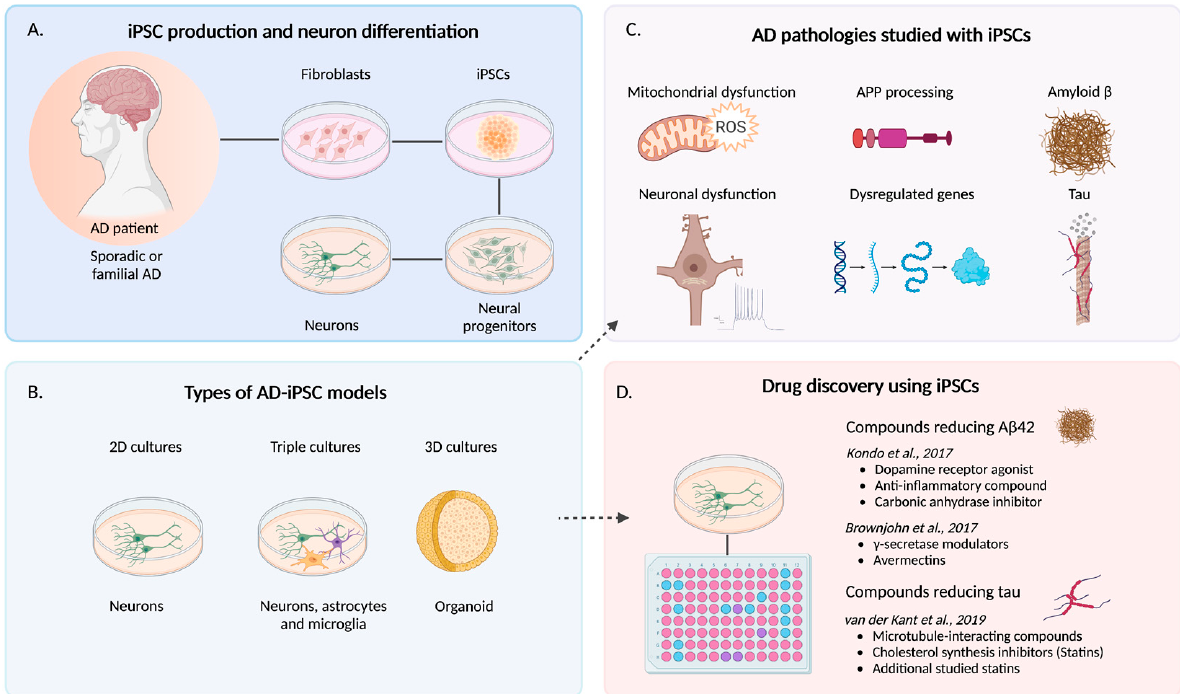
Figure 2. Modeling of Alzheimer’s disease using iPSCs. Human iPSCs are produced from fibroblasts and differentiated into neurons ( A ) that can be cultured in simple 2D conditions, triple cultures, or in 3D as organoids ( B ). Human AD-iPSCs have been used to study several different pathologies including amyloid precursor protein (APP) processing and increased amyloid beta 42 (A β 42), tau phosphorylation and neuronal dysfunction ( C ). AD-iPSCs have also been used to screen and find candidate compounds that can reduce A β 42 and tau ( D ). Created by BioRender.com.